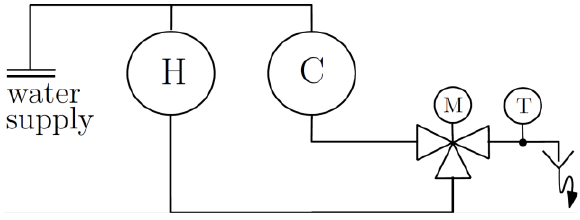
Fig. 1 . Experimental